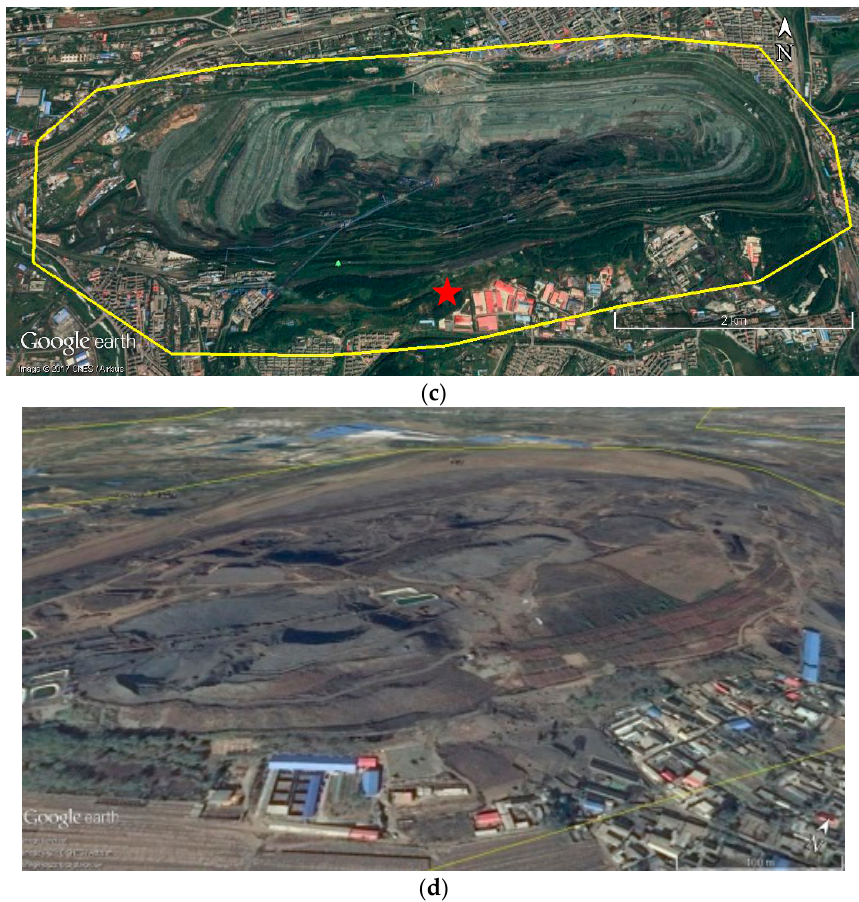
Figure 1. ( a ) Location of the Fushun study area. The red box marks the coverage of the study area in this study. The background is a shaded image of ASTER GDEM. The left-upper inset is an index map to mark the location of the study area in China. ( b ) Locations of five typical regions in the study area. The yellow polygons indicate the boundaries of the typical regions, which are the main open mining areas and waste rocks piling fields in the study area. The red triangles mark the locations of ground control points used in this area. The base image was captured by China’s ZY-3 satellite in October in 2015. ( c ) The scene of the west open-pit mine from Google Images in 2017. The pentacle indicates the location of Qiantai Mountain. ( d ) The scene of the Wangliang waste rocks field from Google Images.